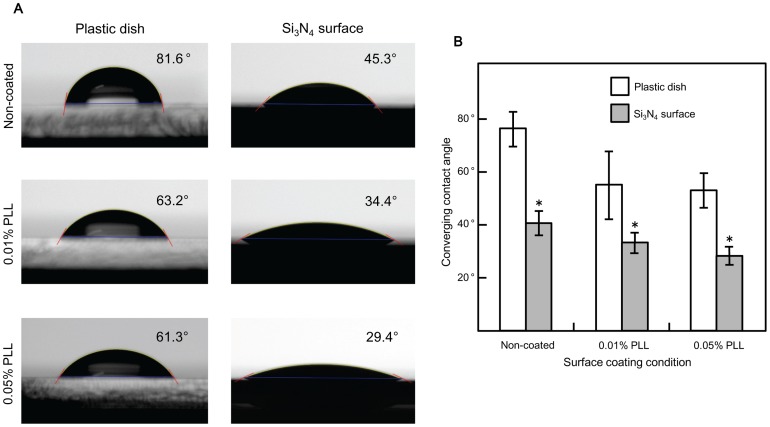
Analysis of the effect of poly-L-lysine coating on contact angles.(A) Substrates were coated with poly-L-lysine solution for 2 hours and then rinsed with distilled water. After overnight drying (∼16 hours) at room temperature, images were captured using a contact angle analyzer. The angle was calculated using the instrument software and the values shown represent the averages of the angles from both sides of the droplet. Non-coated surfaces were also tested for comparative purposes. Each picture is representative for each sample group. The light square observed in the center of the droplet of the pictures taken to the plastic dish samples corresponds to the area where light passes perpendicularly through the water so that refraction does not happen, a similar effect than the one produced by a spherical lens when illuminated. It is important to mention that the light source was located at the opposite side of the water droplet in relation to the camera lens. (B) Plastic culture dishes and Si3N4 surfaces were left untreated or coated with 0.01% or 0.05% poly-L-lysine. A contact angle analyzer was used to measure sessile drop contact angles. Values are the mean ± S.E. for twenty samples (Two trials of ten samples each). *, p<0.001 vs. plastic culture dish.